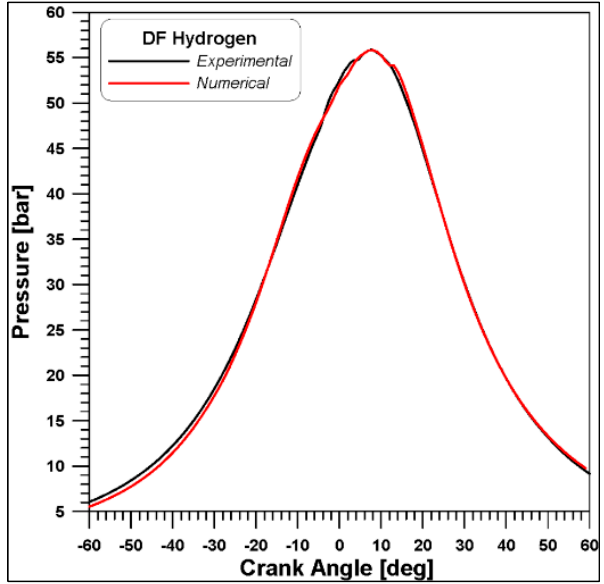
Figure 13. In-cylinder pressure. Experimental vs. Numerical.